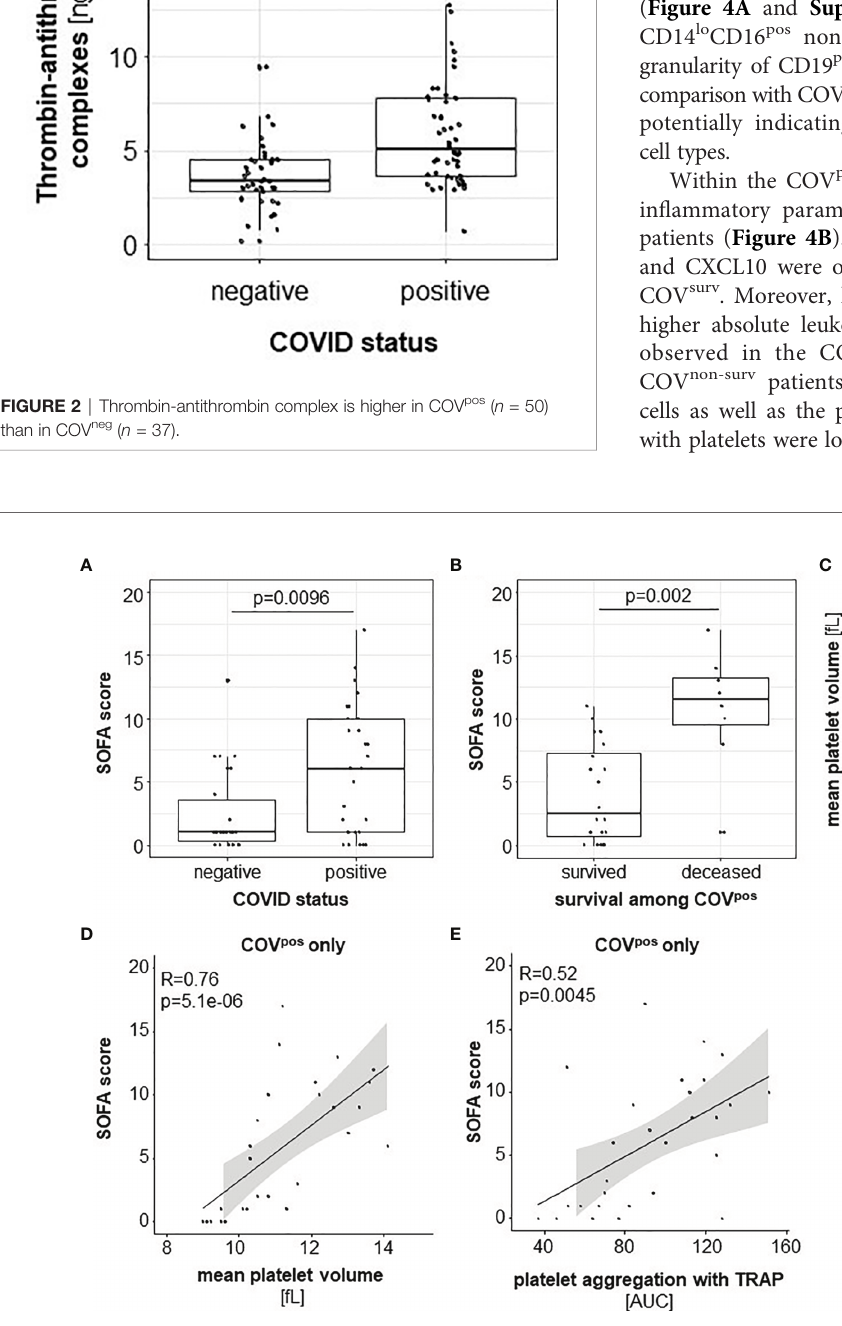
FIGURE 3 | Disease severity indicated by the SOFA score was higher in COV pos ( n = 50) than in COV neg ( n = 37) patients (A) and higher among COV non-surv ( n = 10) than COV surv ( n = 40) COV pos patients (B) . MPV was higher in COV non-surv than in COV surv COV pos patients (C) . Within COV pos , SOFA score correlated with MPV (D) and TRAP-initiated platelet activation (E) .